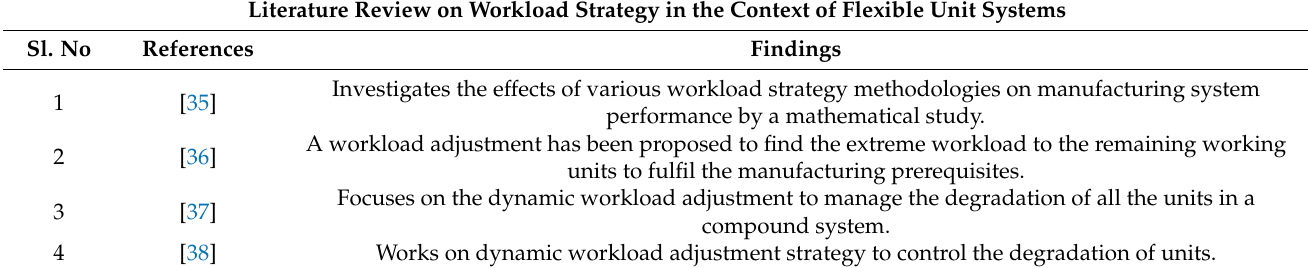
Table 8. Literature review on workload strategy related to flexible unit